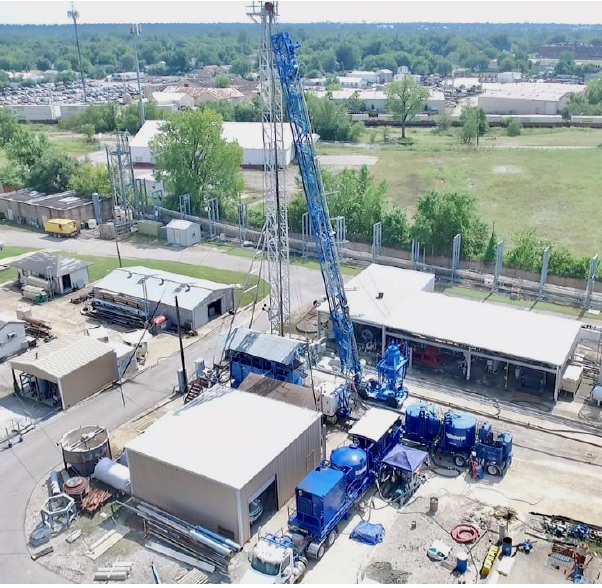
Figure 4. Flow rig built for this study.